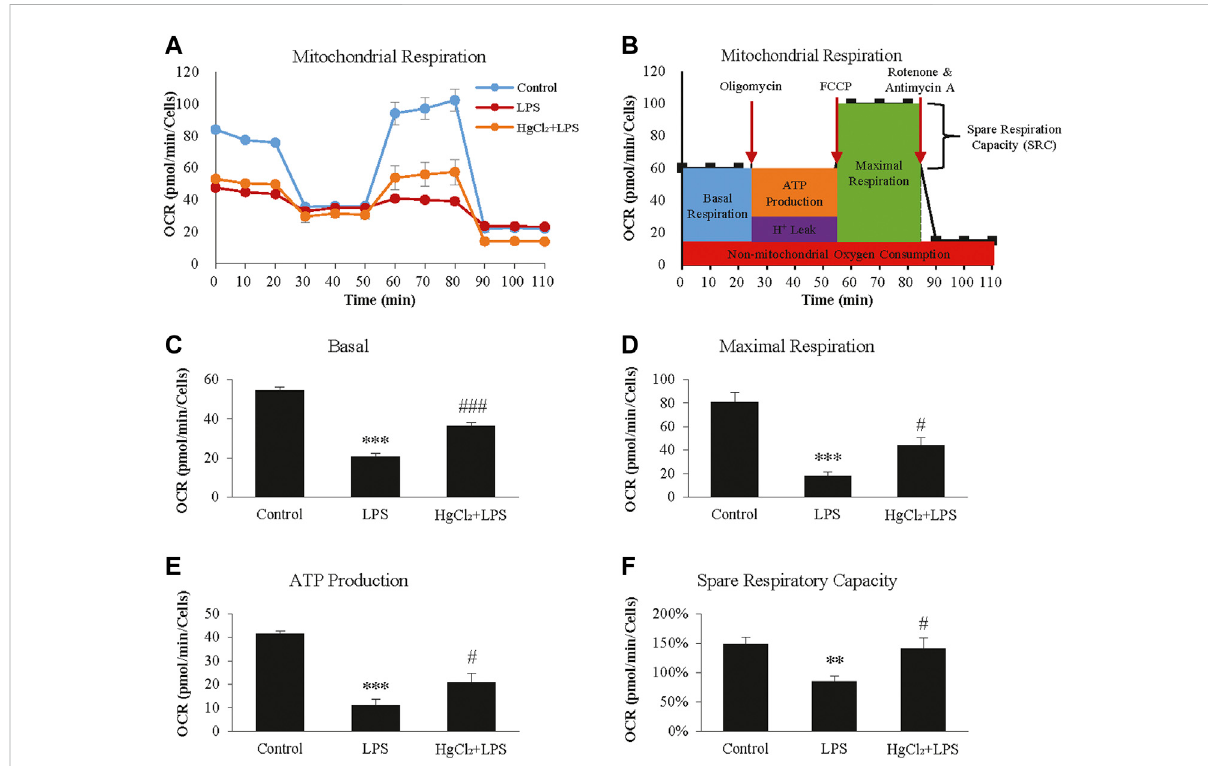
FIGURE 5 HgCl 2 reduces lipopolysaccharides (LPS)-induced mitochondrial stress of bone marrow-derived macrophages (BMDM). (A) Oxygen consumption rates (OCR, in pmol/min) pro fi le of BMDMs after 8 h of LPS (1 μ g/ml) and HgCl 2 (1 μ M) treatment. (B) Schematic diagram of how the fundamental parameters of mitochondrial function measured by XF Cell Mito Stress Test Kit. Calculated basal (C) , maximal respiration (D) , ATP production (E) , and spare respiratory capacity (F) . All measurements were normalized for cell count (n = 4). Values are mean ± SEM. ** p < 0.01 vs. control. *** p < 0.001 vs. control. # p < 0.05 vs. LPS. ### p < 0.001 vs.